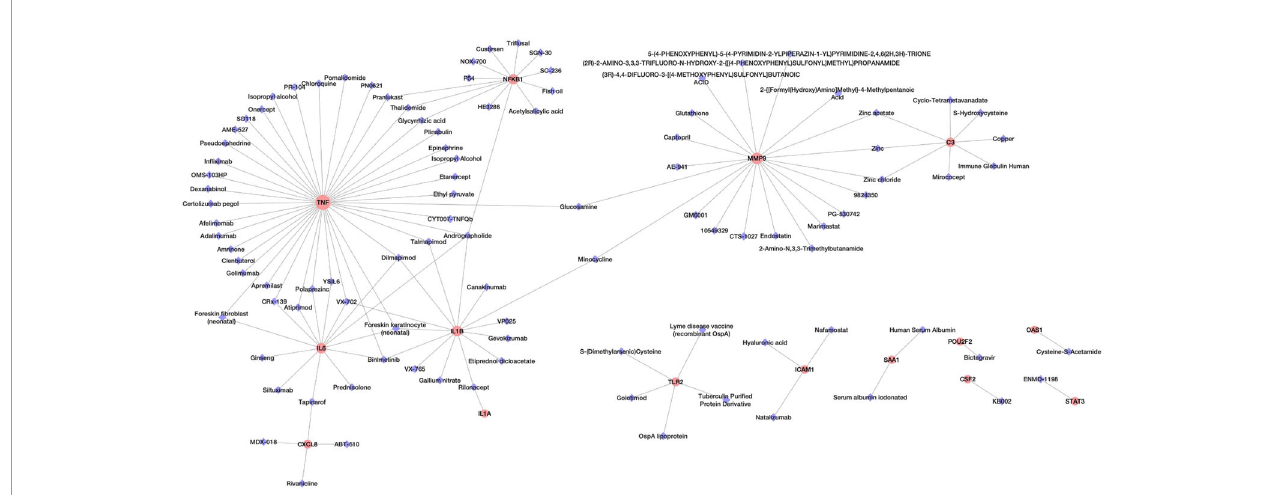
FIGURE 2 | The network of drug molecules targeting the “ host response signature network ” .